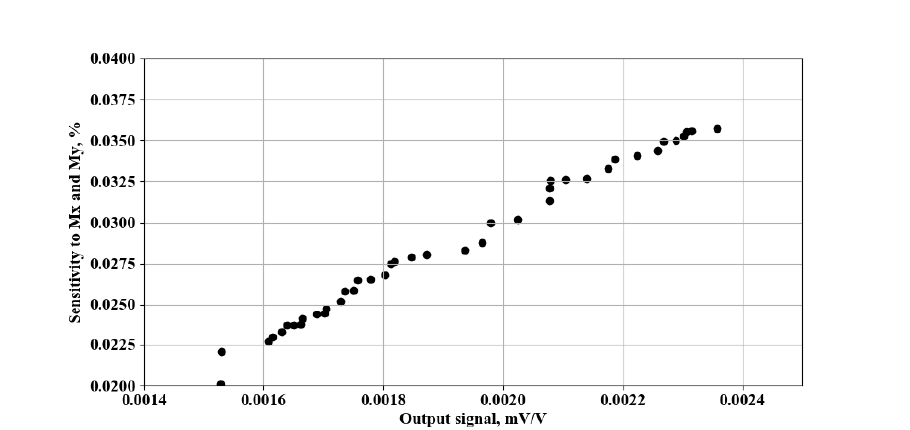
Fig. 6 . User interface of the module for managing algorithm settings.